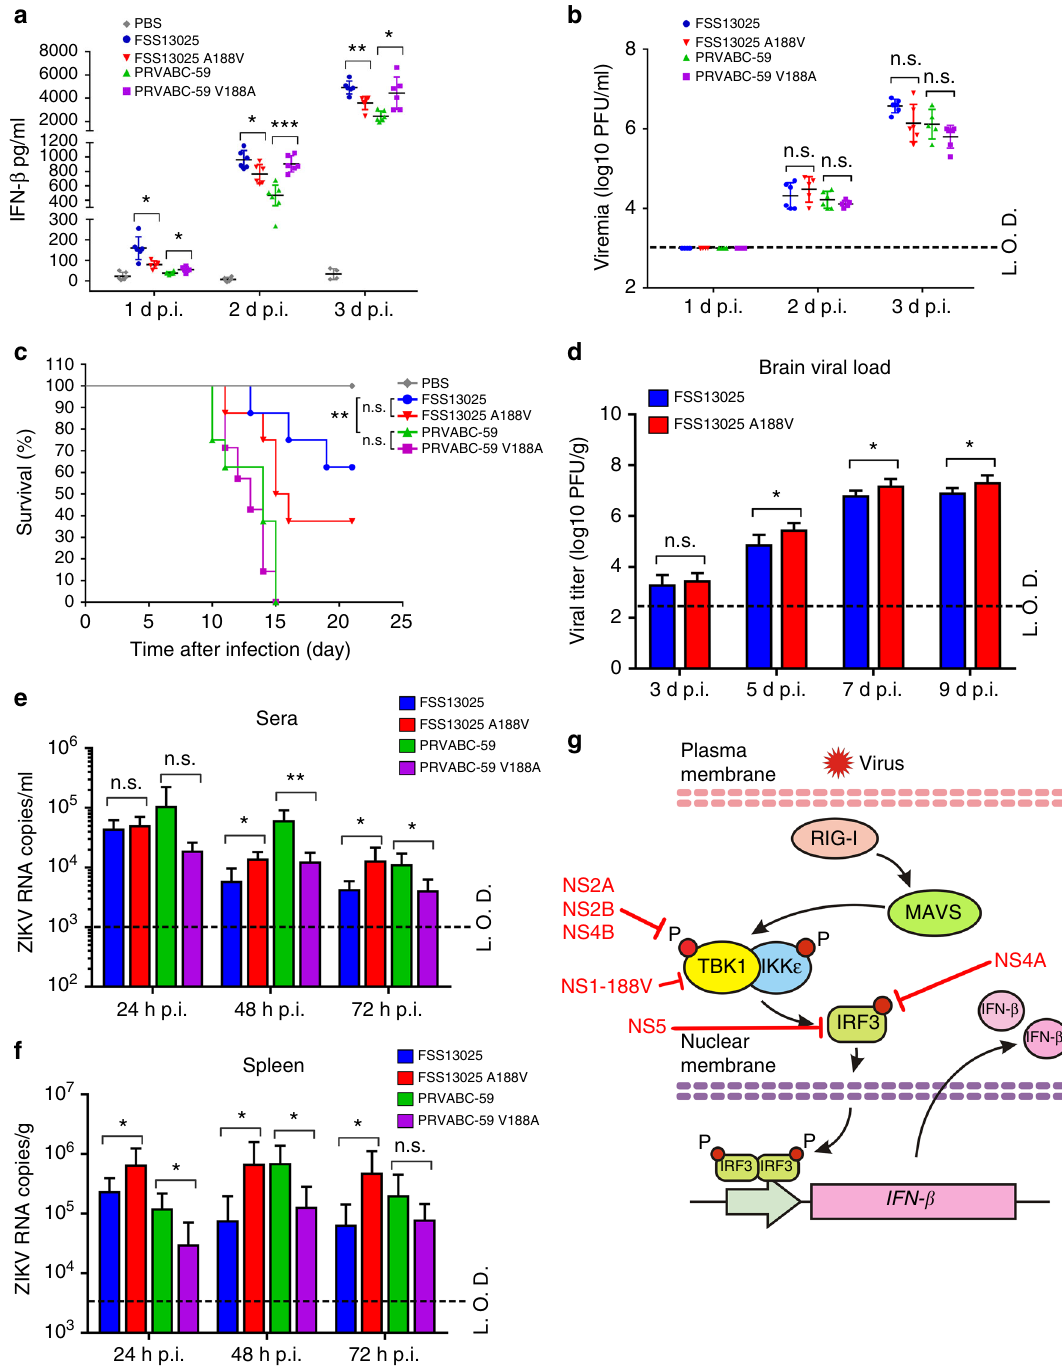
Fig. 7 IFN- β protein expression in A129 mice and neurovirulence analysis in neonate CD-1 mice. Five groups of three-week-old A129 mice ( n = 6) were intraperitoneally infected with 1 × 10 5 PFU of FSS13025 WT, FSS13025 A188V, PRVABC-59 WT, PRVABC-59 V188A virus, or phosphate-buffered saline (PBS). Mouse blood were collected at days 1, 2, and 3 p.i., sera were separated and applied for IFN- β measurement by ELISA ( a ), and viremia were determined by plaque assay on Vero cells ( b ). c Comparison of neurovirulence of FSS13025 WT, FSS13025 A188V, PRVABC-59 WT, and PRVABC-59 V188A virus in CD-1 newborn mice. Groups of one-day-old CD-1 mice ( n = 8 per group) were infected with 1 × 10 3 PFU through the intracranial route. Survival curves are presented. d Two groups of one-day-old CD-1 mice ( n = 5) were infected with 1 × 10 3 PFU of FSS13025 WT and its corresponding A188V viruses through the intracranial route. Mouse brains were harvested at days 3, 5, 7, and 9 post-infection. Viral loads in brain were determined by plaque assay on Vero cells. e , f Four groups of C57BL/6J mice ( n = 4 per group) were intraperitoneally infected with 1 × 10 5 PFU of FSS13025 WT, FSS13025 A188V, PRVABC-59 WT, or PRVABC-59 V188A virus. Mouse blood and spleen were collected at 24, 48, and 72 h post-infection. Viral RNA in sera and spleens were extracted and quanti fi ed by qRT-PCR. Data are shown as means ± SD, * P < 0.05, ** P < 0.01, or no signi fi cance (n.s.) through Student ’ s two-sided t- test. L.O.D., limit of detection. g Summary of ZIKV non-structural proteins targeting different components of the RIG-I pathway. See text for